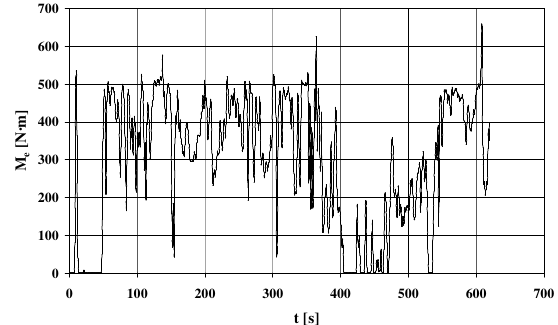
Fig. 2. Engine torque – M e vs. time – t curve, recorded in the NRTC test